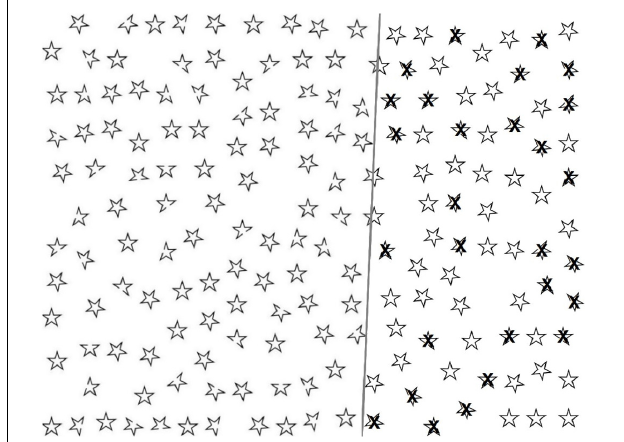
FIGURE 1 | The large-screen Twinkle Task: demonstrations of empty task sheet (left), and correctly selected targets (right).